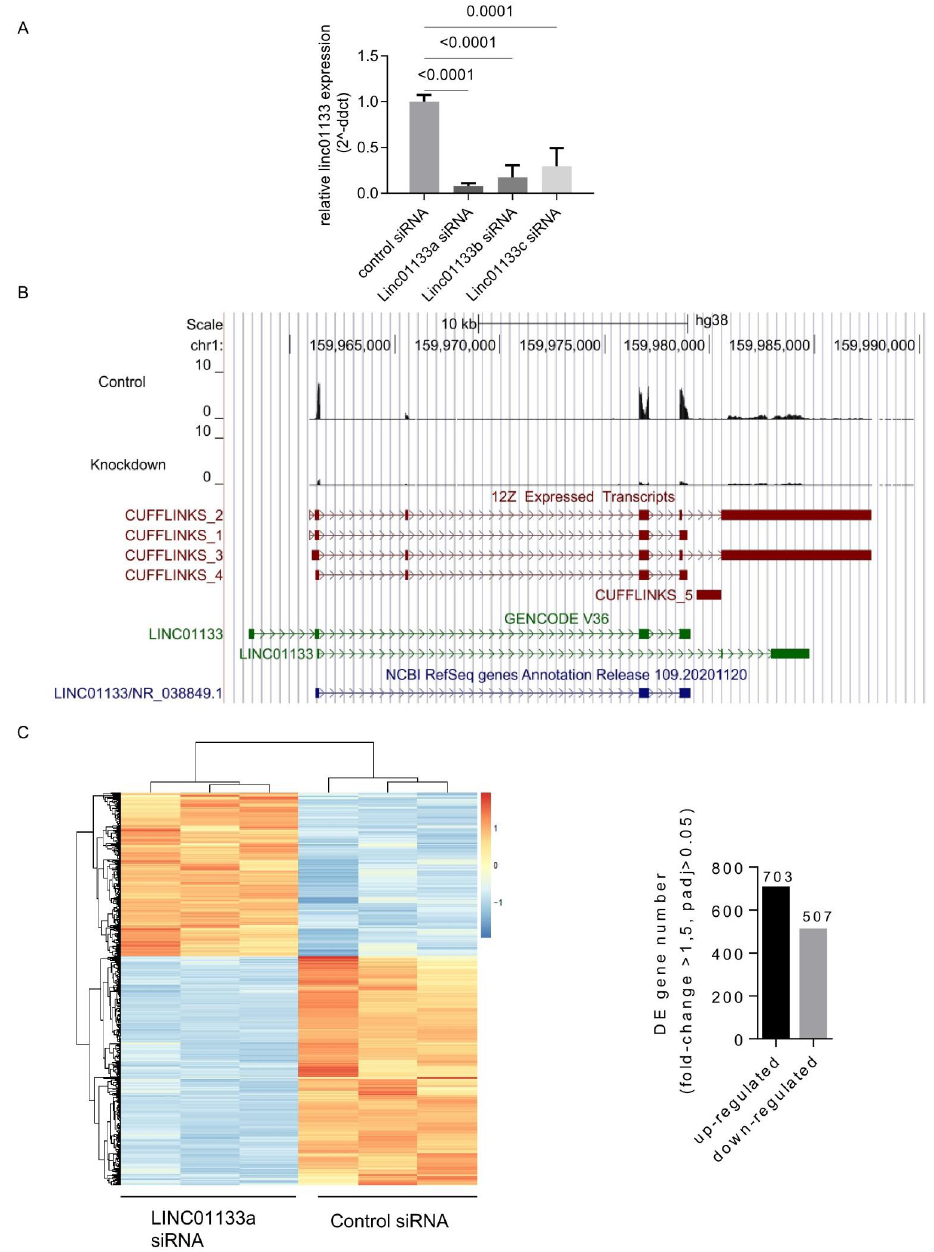
Figure 2. LINC01133 knockdown leads to the deregulation of hundreds of genes in an endometriosis epithelial cell